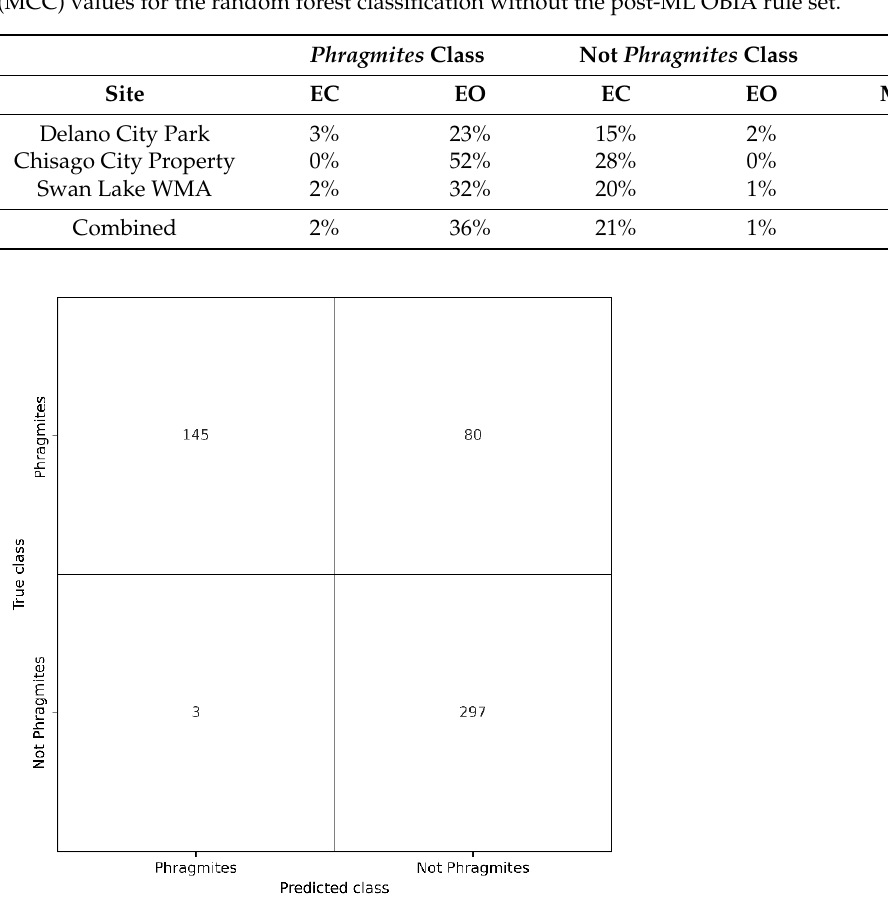
Figure 11. Combined confusion matrix for the three validation sites classified using a random forest without the post-ML OBIA rule set. A classification accuracy of 84% was achieved. The Phragmites class had a producer’s accuracy of 64% and a user’s accuracy of 98%. The Not Phragmites class had a producer’s accuracy of 99%, while achieving a user’s accuracy of 79%.